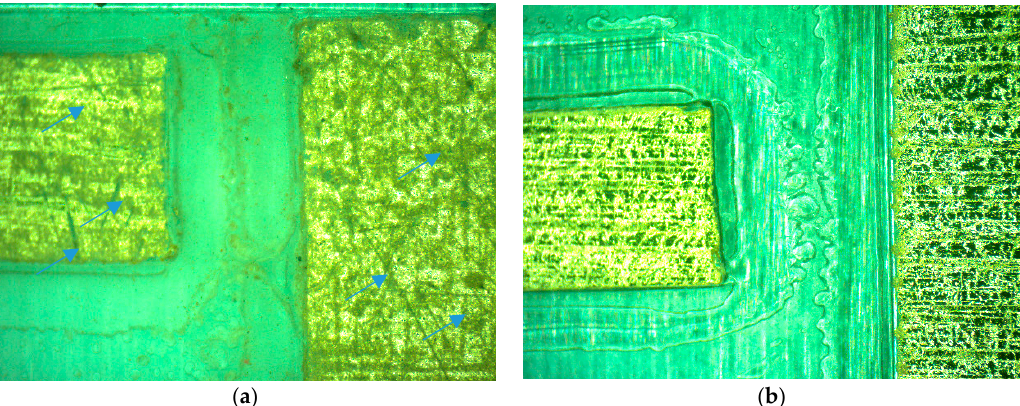
Figure 8. Magnified gold electrode segment of an interdigitated capacitive structure for ( a ) a sensor used more than 60 times, degraded with many scratches (labelled with arrows), and ( b ) for a new fabricated